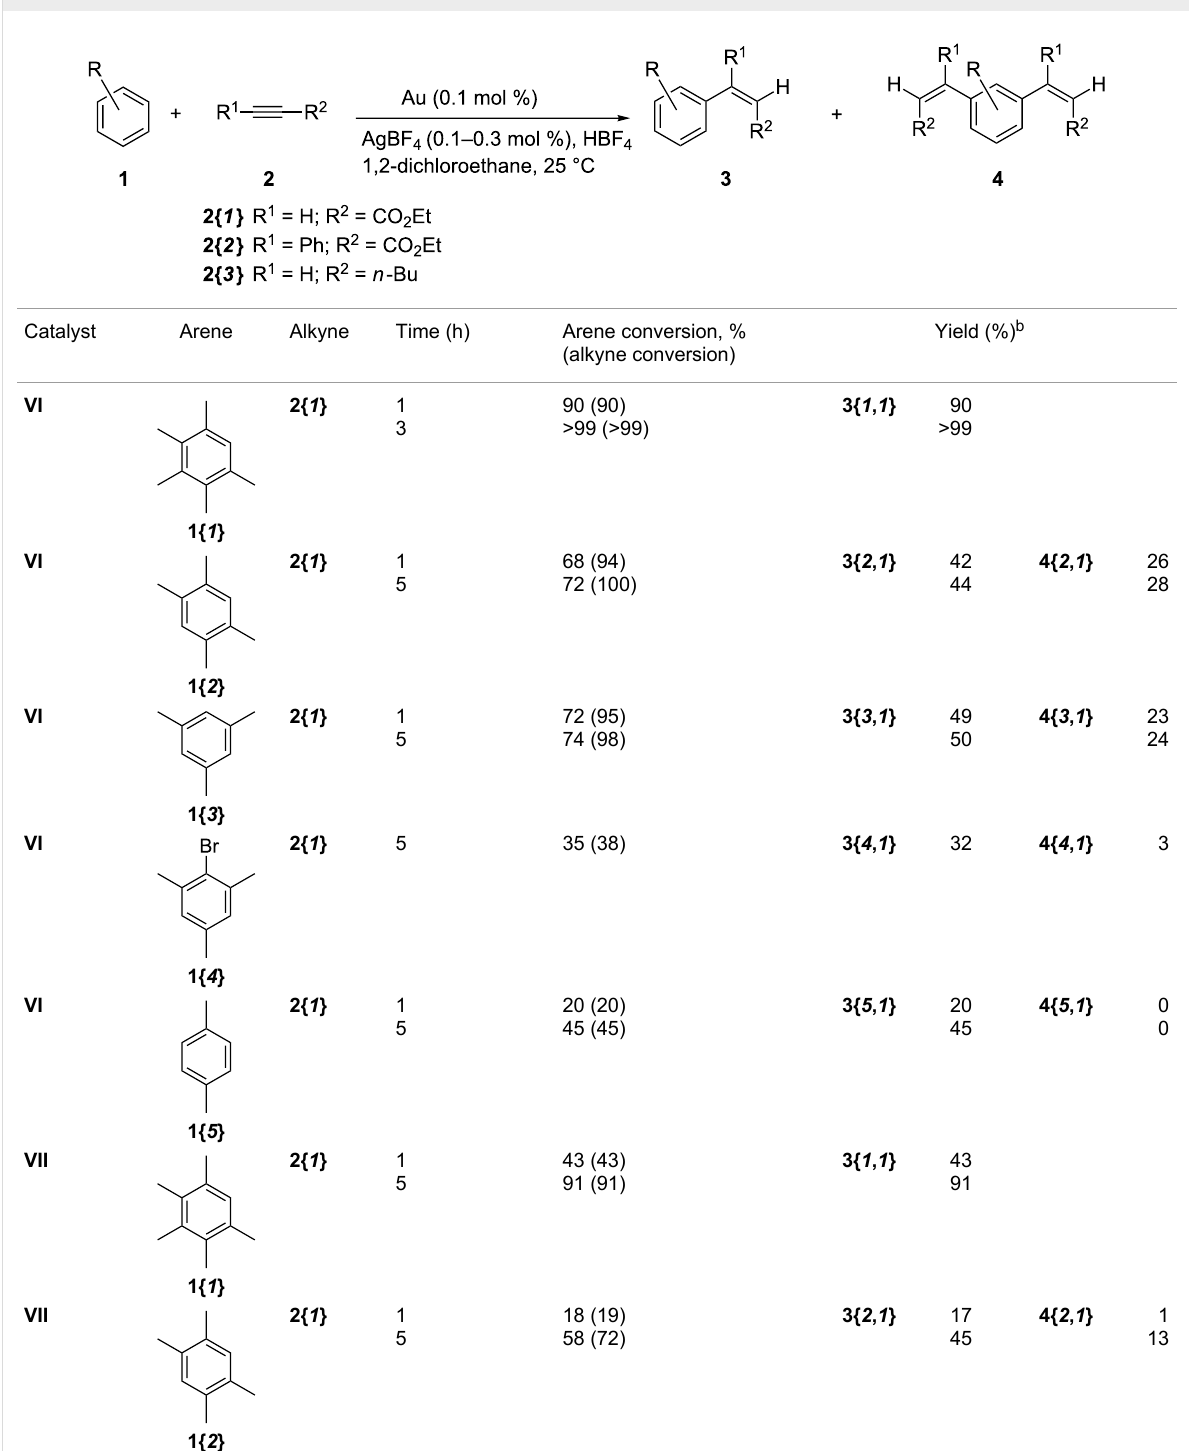
Table 1: Hydroarylation of alkynes using gold NHC catalysts: screening of different arenes and alkynes. a